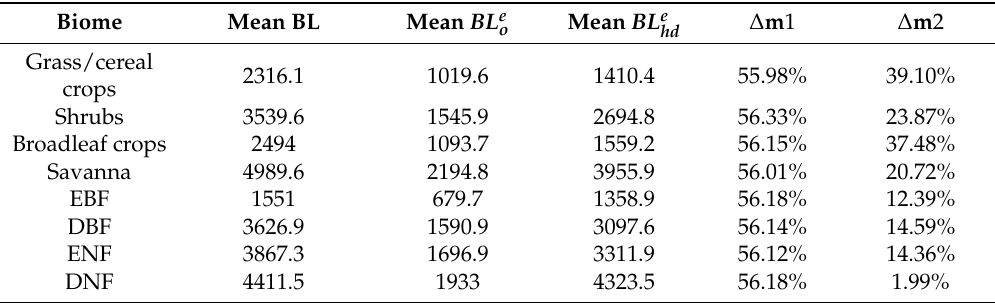
Table 3. Comparison of the mean boundary lengths of typical biomes for boundary length (BL), BL e o , and BL e hd